Question: Briefly state, in one sentence, what is plotted here.
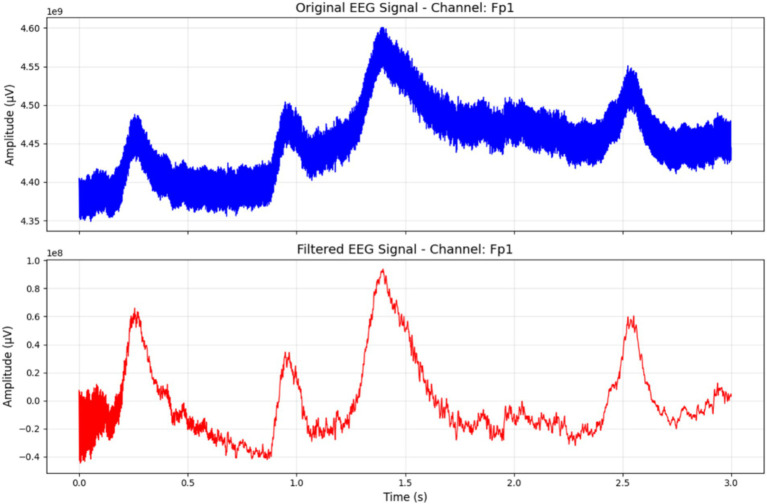
Answer: EEG signal preprocessing for channel Fp1. The upper panel shows the raw EEG signal acquired from the Fp1 electrode. The lower panel shows the corresponding preprocessed signal after filtering.